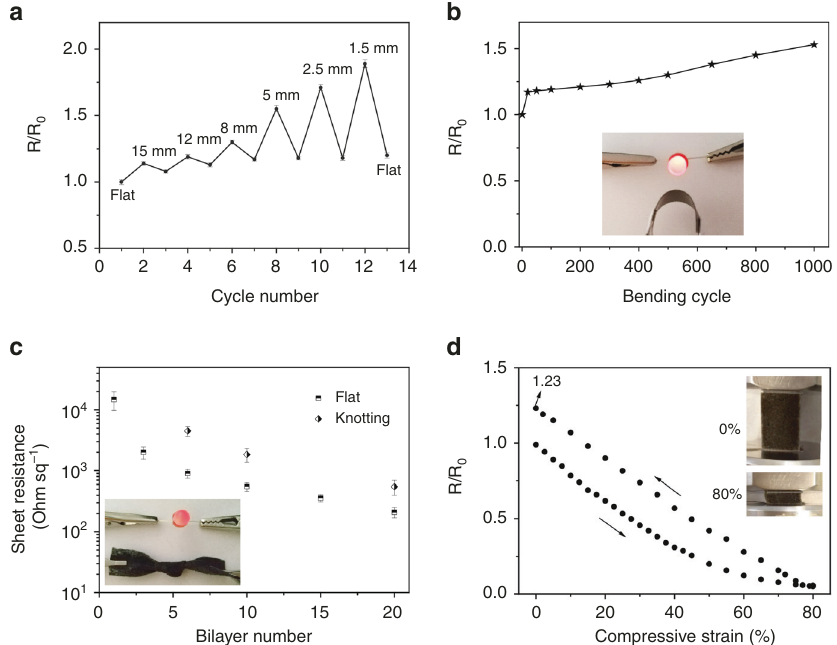
Fig. 4 Electromechanical properties of (MXene/TAEA) n multilayers. a Normalized resistance R / R 0 ( R 0 = 1.63 k Ω ) as a function of bending radius and b cyclic stability with a bending radius of 5 mm of (MXene/TAEA) 10 on PET sheet. Inset in b shows a digital photograph of (MXene/TAEA) 20 on PET sheet under bending condition with a LED connection. c Sheet resistances of (MXene/TAEA) n on nonwovens at fl at and the knotted conditions. Inset shows a digital photograph of knotted (MXene/TAEA) 30 on nonwoven with a LED connection. d Normalized resistance R / R 0 ( R 0 = 36.2 k Ω ) as a function of compressive strain for the (MXene/TAEA) 6 on melamine foams, and the inset shows a photograph of the compression/resistance measurement for (MXene/TAEA) n on foams in uncompressed and with 80% compressive